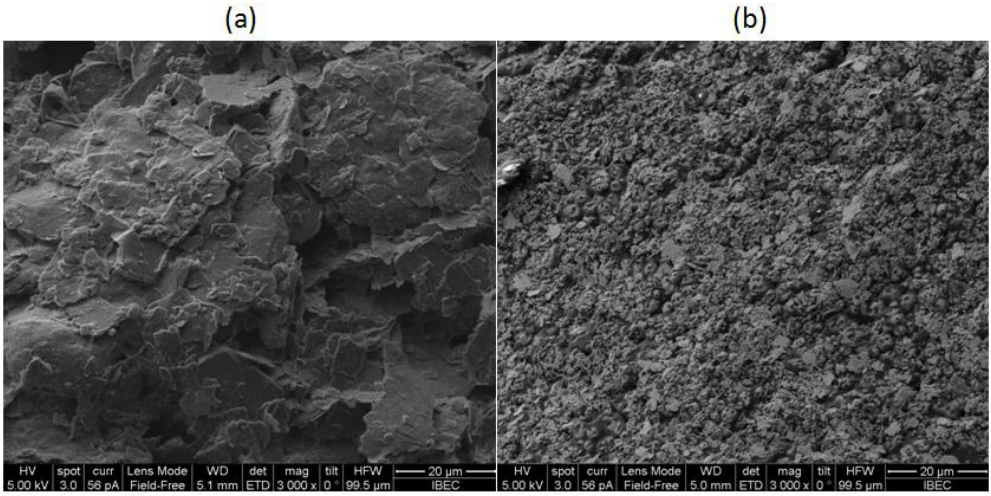
Figure 4. SEM results of carbon ( a ) and Ag/AgCl ( b ) surfaces.